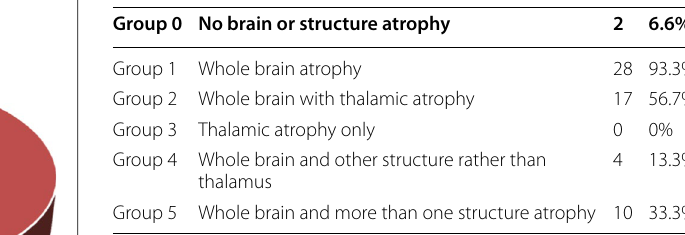
Table 8 Grouping of MS